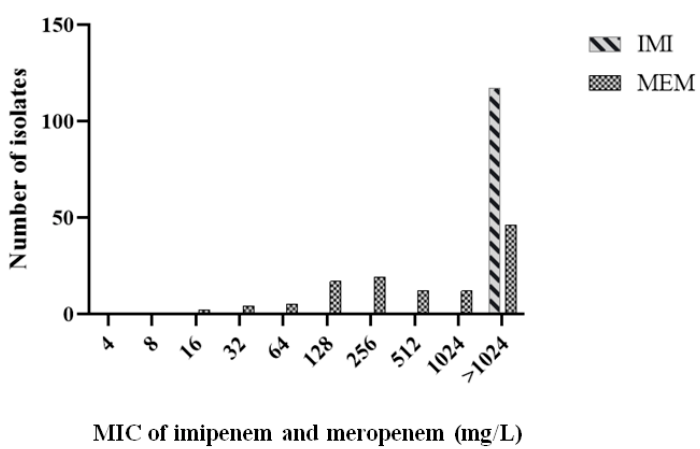
Figure 3. The distribution of the minimum inhibitory concentration MIC values of imipenem (IMI) and meropenem (MEM) among isolates. For both antimicrobial agents, the MICs for the resistant isolates were ≥ 4 mg / L according to CLSI (M100-S26, 2016) guidelines.